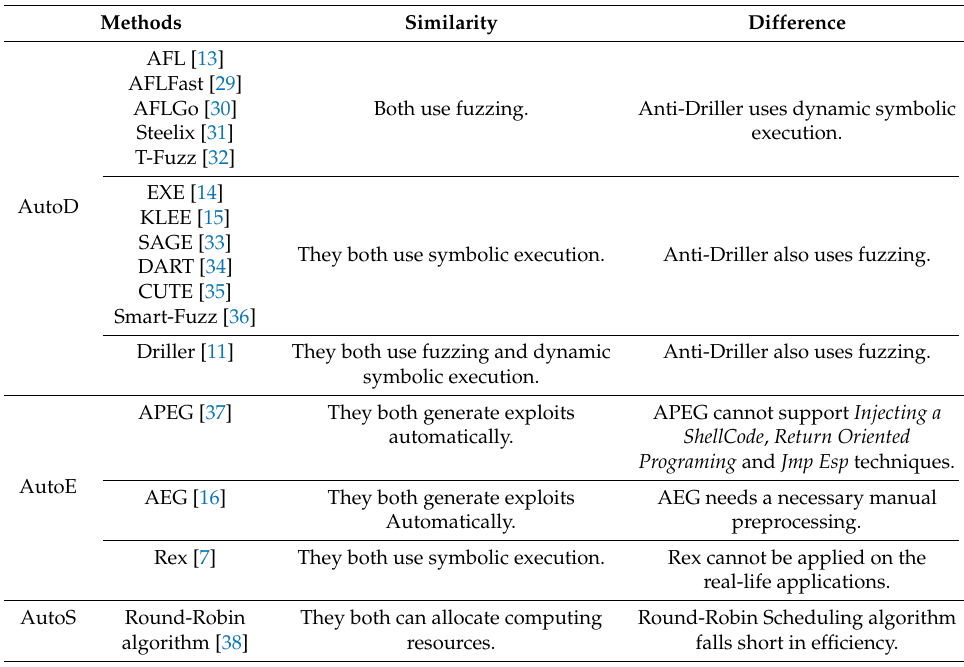
Table 1. The comparison between the existing methods and our proposal AutoDES.